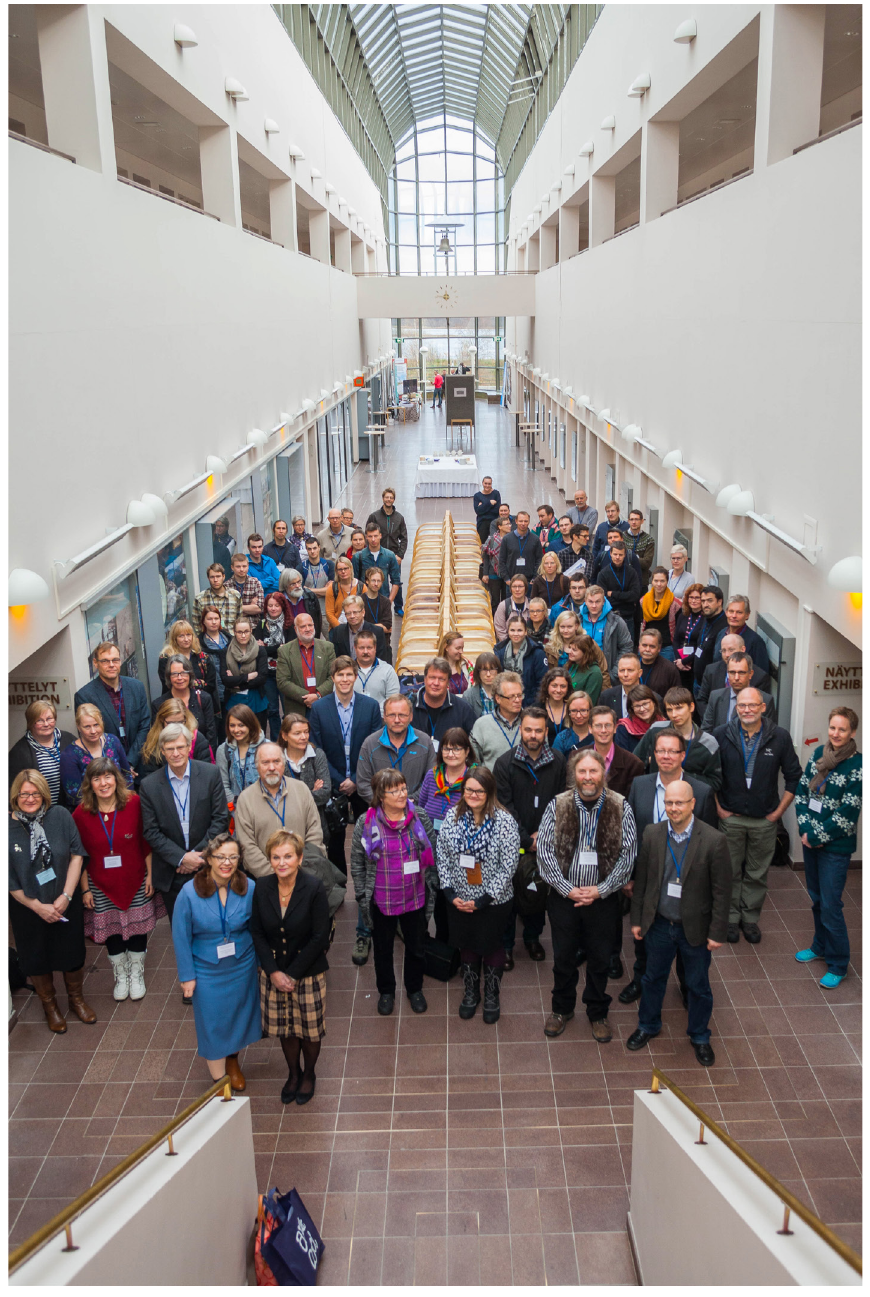
Figure 1. Seminar participants from Finland, Norway, Sweden, Denmark, Greenland, Germany, UK and Hungary at the conference venue; the Arktikum, Rovaniemi (Photo: Veli